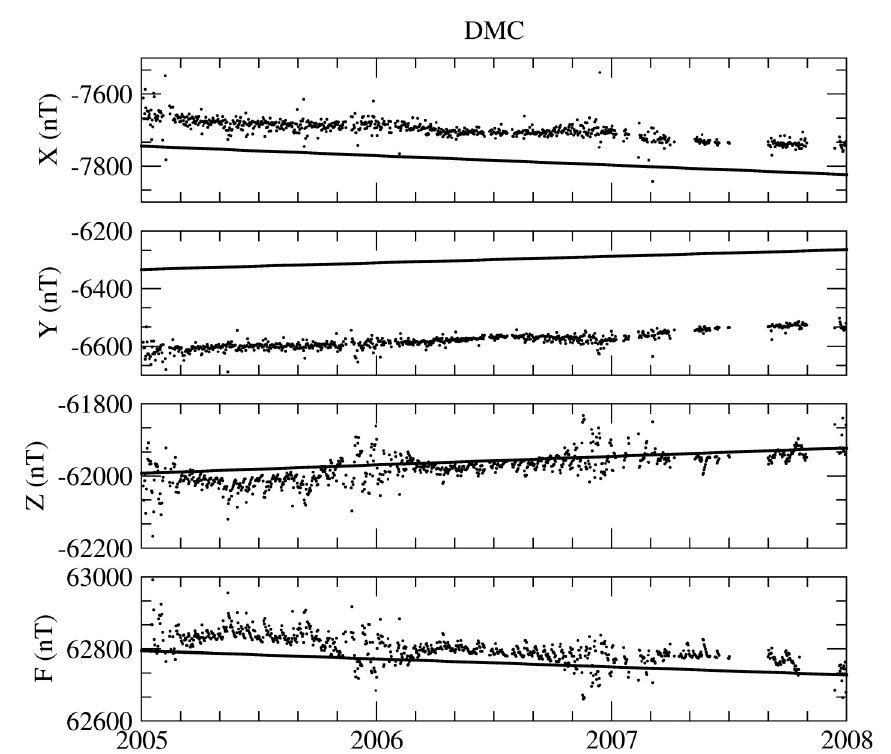
Fig. 11. Comparison of the daily mean values of the absolute field with the field predicted by IGRF10 mod- el. Note the fairly good agreement for components Z and F and the discrepancy for X and Y components, amounting around 80 and -270 nT respectively (observed minus predicted values). In any case, there is a good agreement in secular